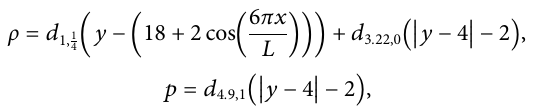
Frontiers in Physics |